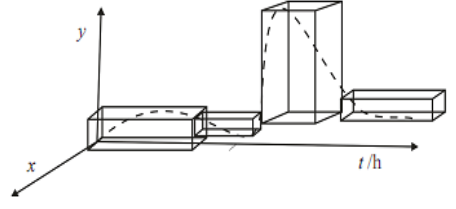
Fig.3. Illumination of a trajectory represented by